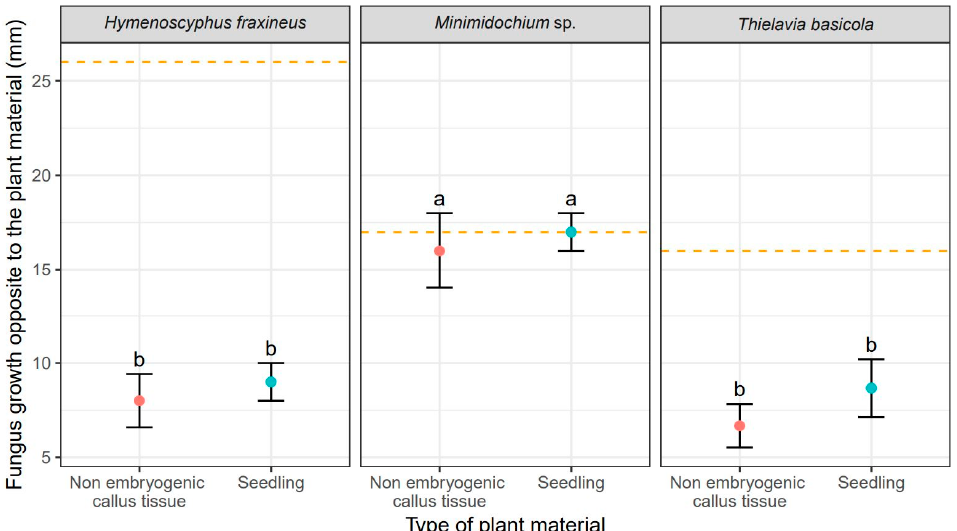
Figure 2. Mean values (points) and standard deviation s (error bars) for fungus size in the direction opposite to the plant material (red—non embryogenic callus tissue, light blue—seedling). The orange dashed lines show fungus size in the experiments without plant material. The same letters indicate the lack of statistically significant differences ( p < 0.05).